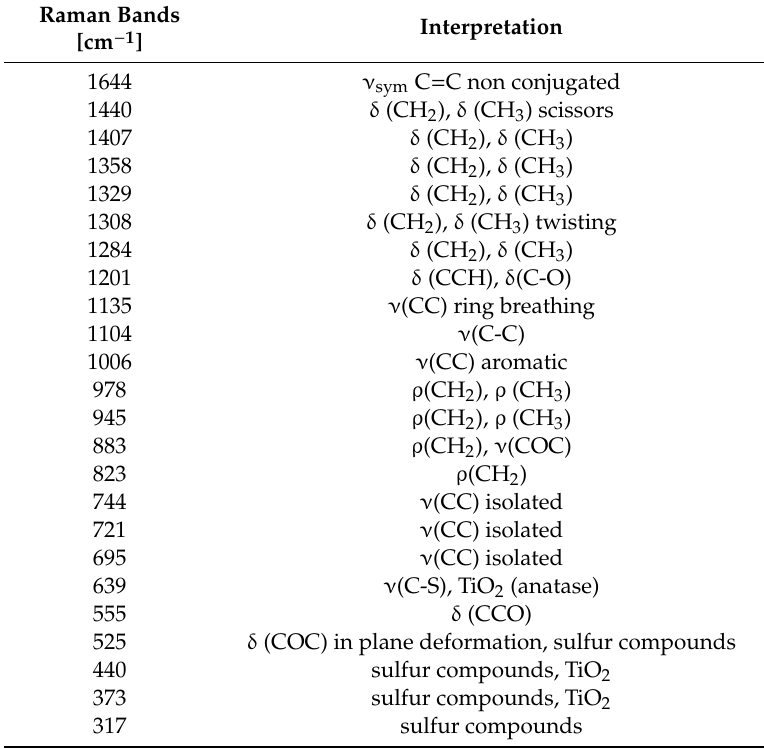
Table 4. Raman bands found in the RS spectra of two types of Dominican fossil resins (see Figure 8A,B) and their assignments